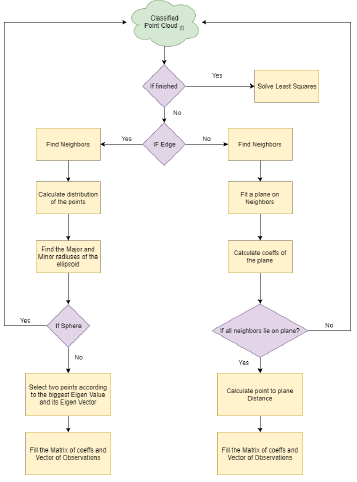
Figure 4. Flowchart of Refining algorithm